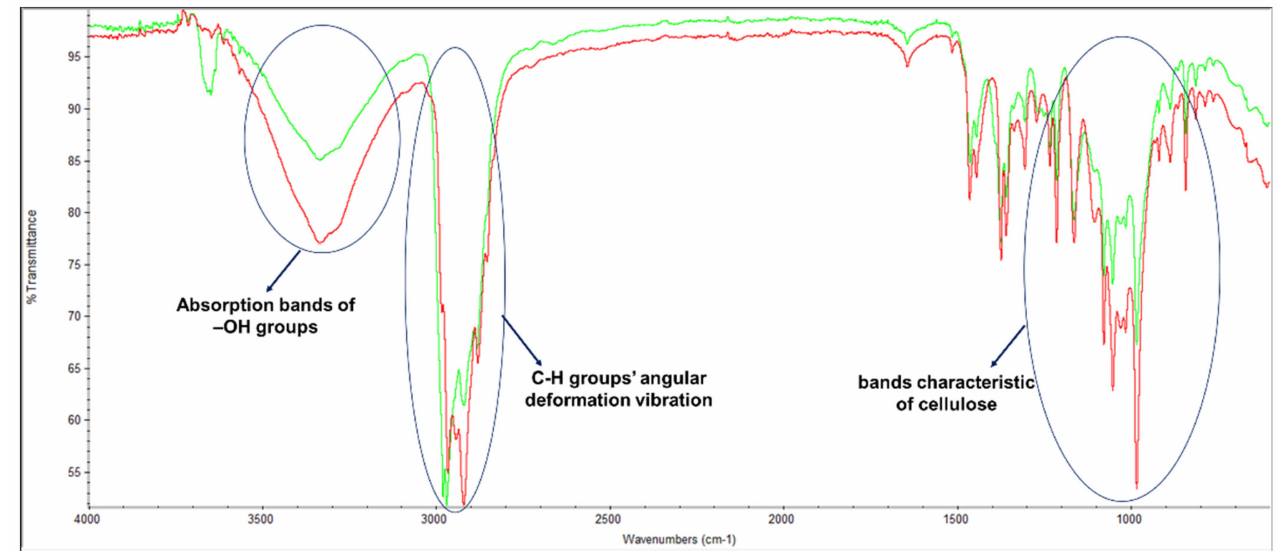
Figure 4. FTIR-ATR spectrum of a eucalyptus pulp (green) and MFC sample